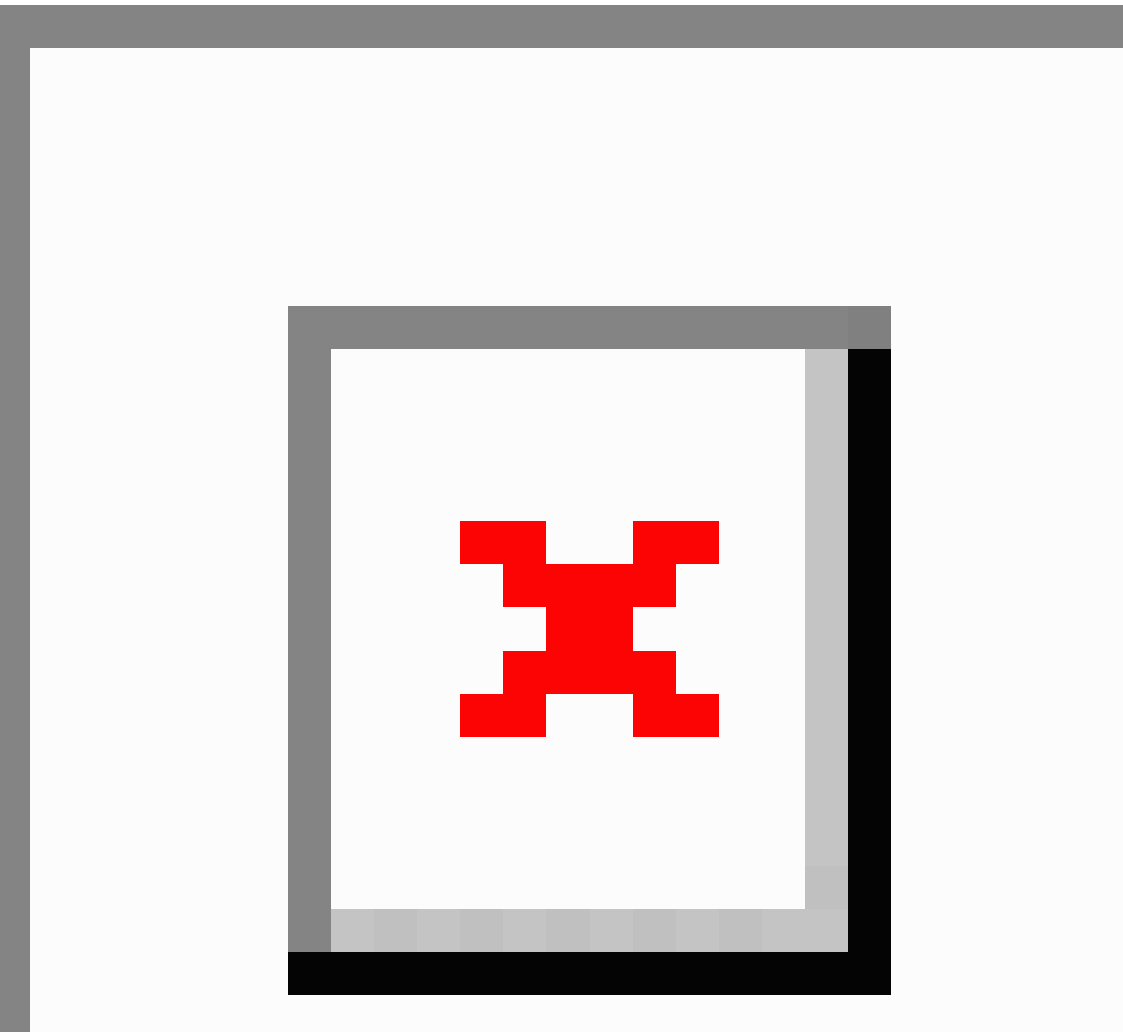
Figure 1. Approximate power curves for the hypothesis that the rate of IHD is higher among men in Holtermann’s group than it is among other blue-collar workers as a function of the true rate ratio